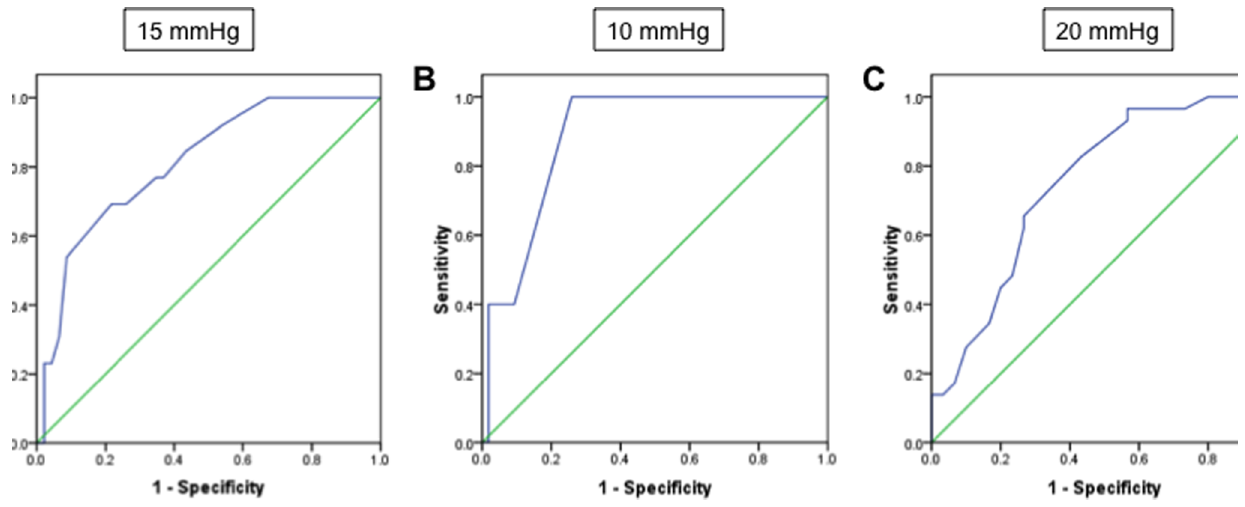
Figure 6. Area under the receiver operating characteristic curve (AUROC) of PCWP against LVEDP in the entire study population. (A) AUROC = 0.81 (95% CI, 0.69 to 0.94) using a cut point of LVEDP # 15 mmHg to indicate pre-capillary PH. (B) If a cut point of LVEDP # 10 mmHg was used, the AUROC would be 0.89 (95% CI, 0.79 to 0.99). (C) If a cut point of LVEDP # 20 mmHg was used, the AUROC would be 0.75 (95% CI, 0.63 to 0.88). Sensitivity=sensitivity for the outcome of LVEDP . 15 mmHg; Specificity=specificity for the outcome of LVEDP . 15 mmHg.